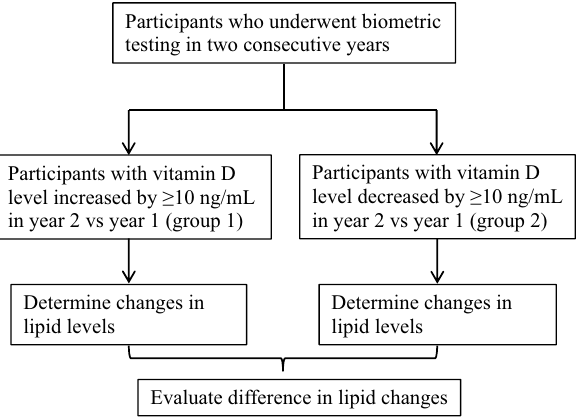
Figure 1. Study design. Selection process of individuals into the study cohort and analysis plan are